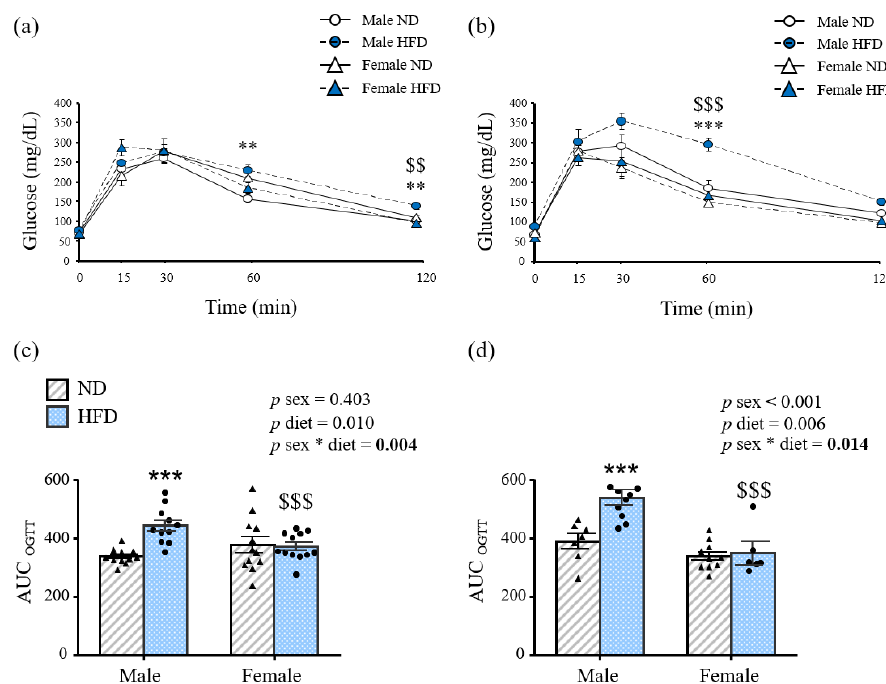
Figure 2. Oral glucose tolerance test of ( a ) 12- and ( b ) 32-week-old mice and area under the curve of ( c ) 12- and ( d ) 32-week-old experimental animals. Data are presented as the mean ± SEM of 6 – 12 animals per group. Statistical differences were analyzed by two-way ANOVA or one-way ANOVA followed by Bonferroni post hoc test if an interaction was detected. * interaction between both fac- tors (sex and diet); ** p < 0.01; *** p < 0.001 vs . male mice fed a ND; $ p < 0.05; $$ p < 0.01; $$$ p < 0.001 vs . female mice fed the same diet. AUC, area under the curve, HFD, high-fat diet; ND, normal diet; OGTT, oral glucose tolerance test. p values lower than 0.05 are highlighted with bold text.